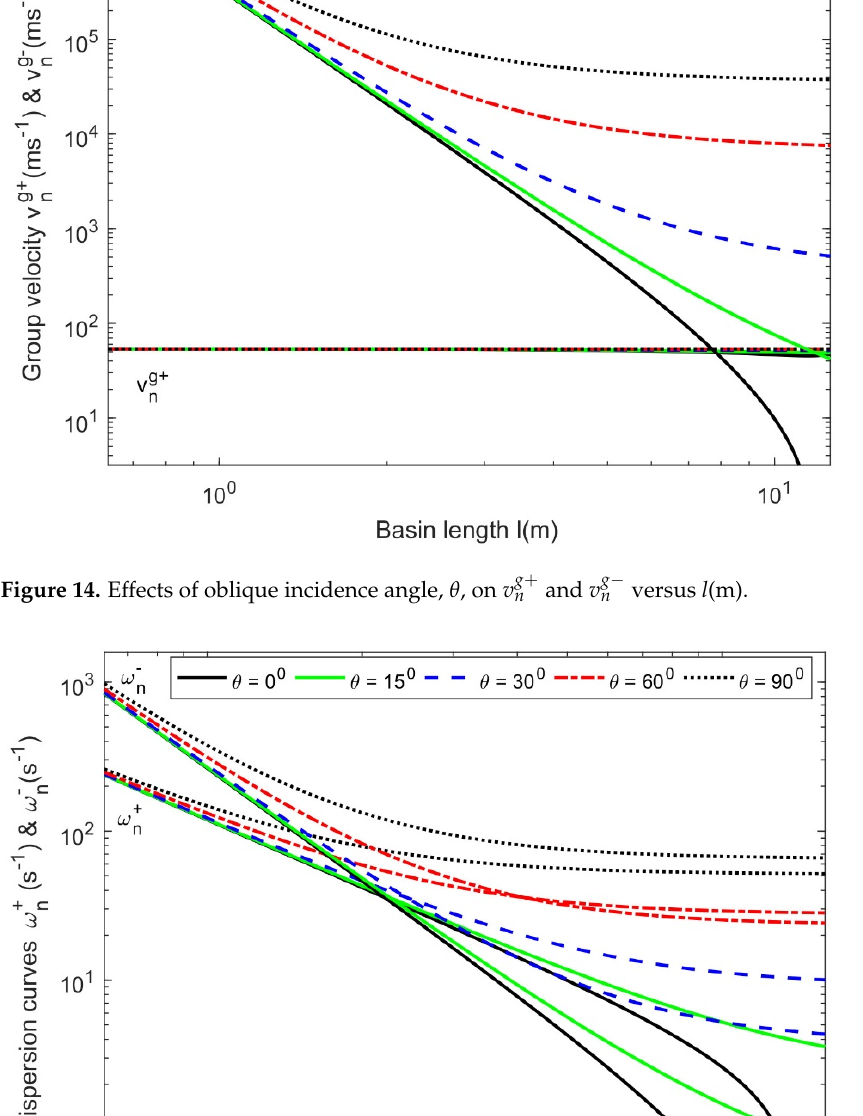
Figure 15. Effects of different oblique angles, θ , on ω + n and ω − n against l